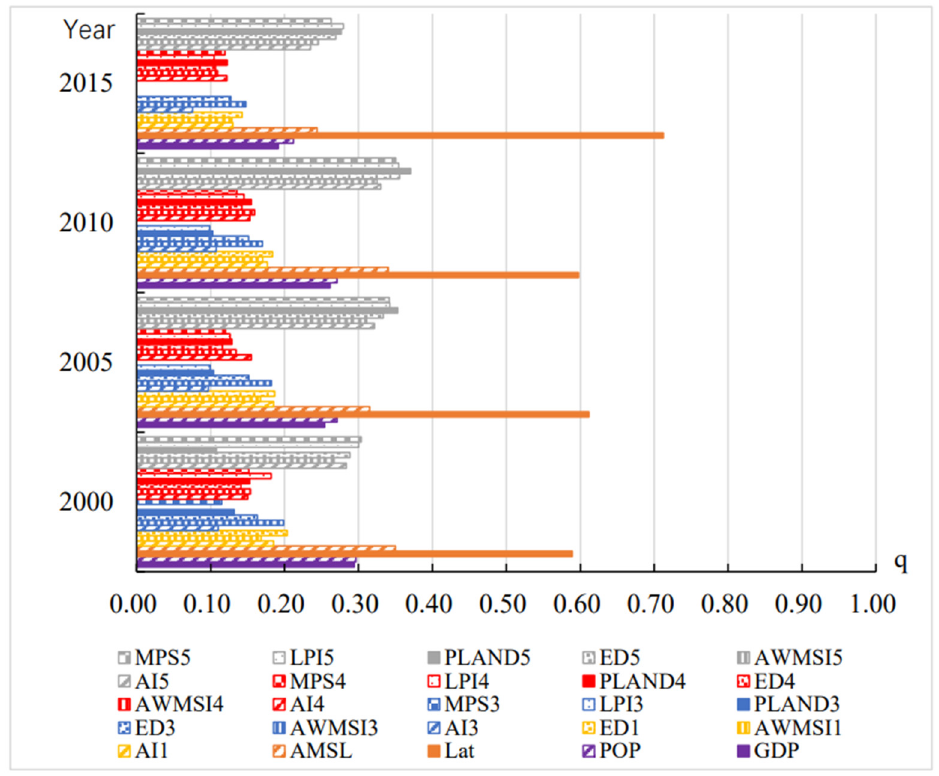
Figure 11. Q statistics between annual frequency of extreme thermal comfort and driving factors (1: cultivated land; 2: green space; 3: water bodies; 4. construction land; 5: unused land).